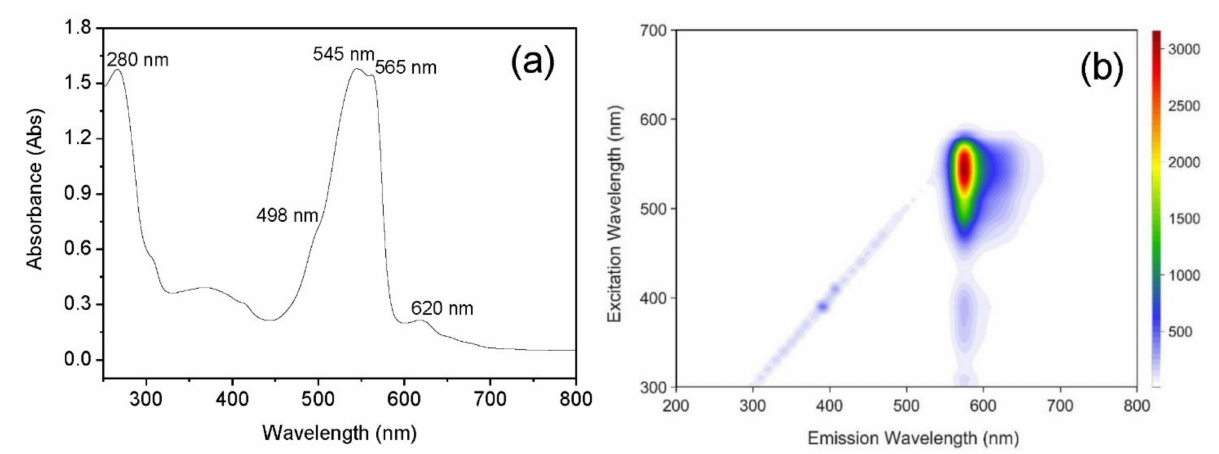
Figure 3. Spectral characteristics of the crude extract of Porphyridium purpureum . ( a ) UV–Vis absorption spectrum